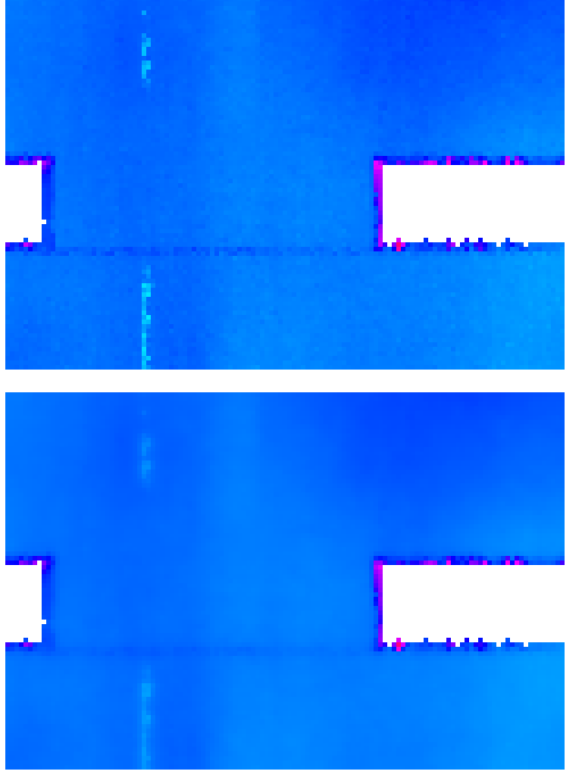
Figure 5: Details of the original model of the facade of Figure (4) (top) and of its smooth approximation (bottom)